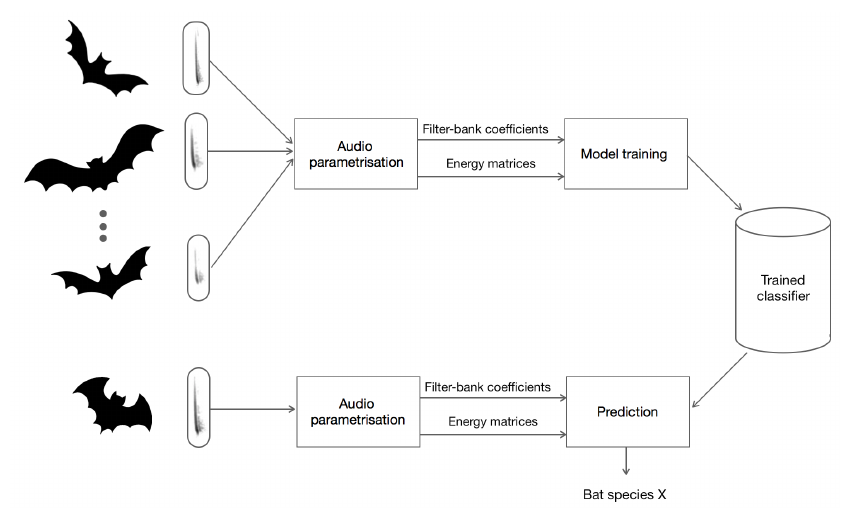
Figure 9. Block diagram of the process used for the automatic classification of the calls contained in an audio file.